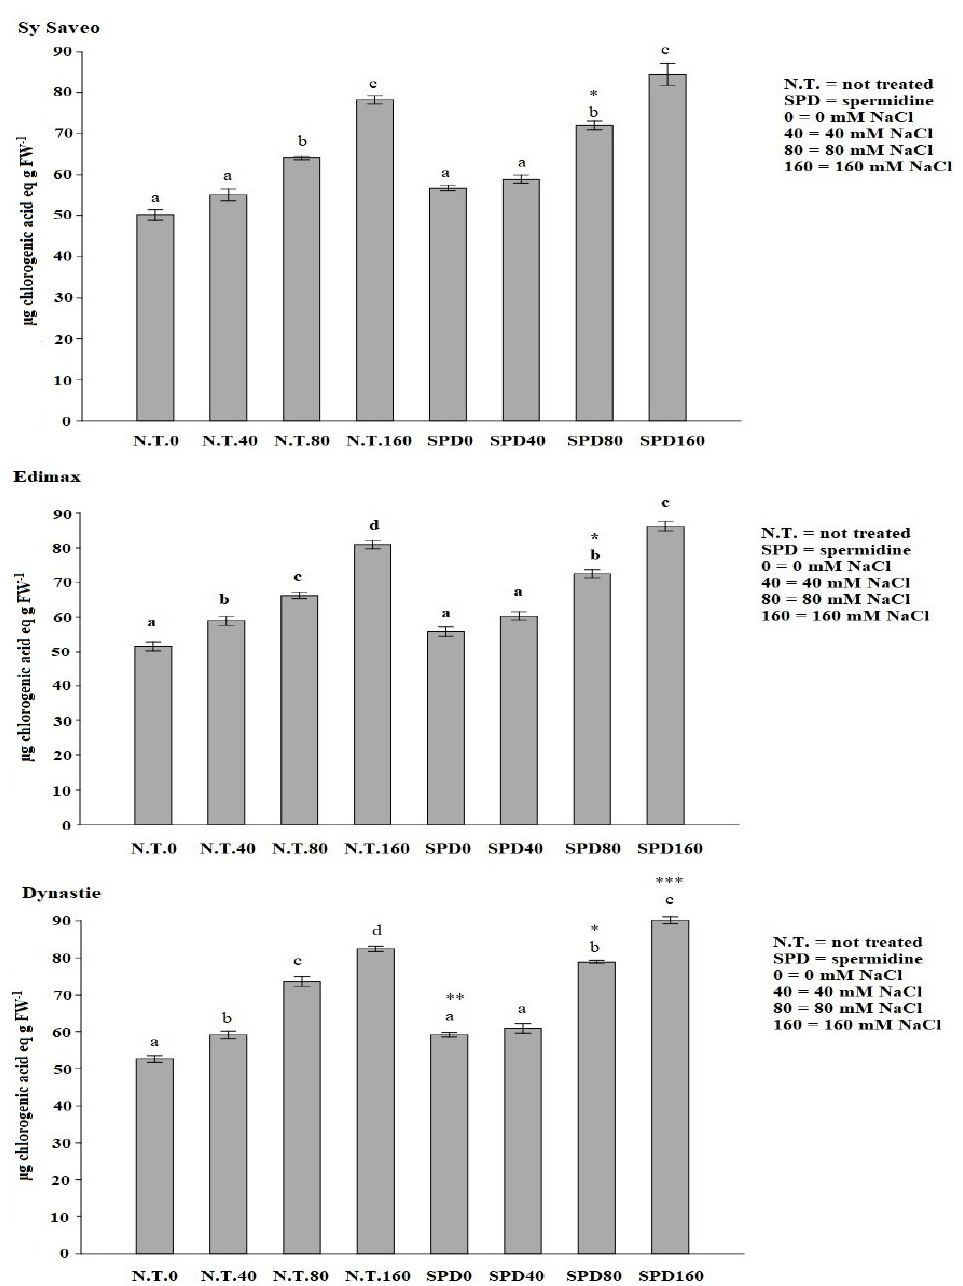
Figure 1. Effect of spermidine priming on total phenol content of rapeseed cultivars exposed to saline conditions. Data are expressed as means ± SE ( n = 3). Mean values in the column marked by different letters are significantly different within the same group ( p ≤ 0.05; ANOVA and Tukey–Kramer test). Significant differences between groups are reported as * p < 0.05; ** p < 0.01; *** p < 0.001.